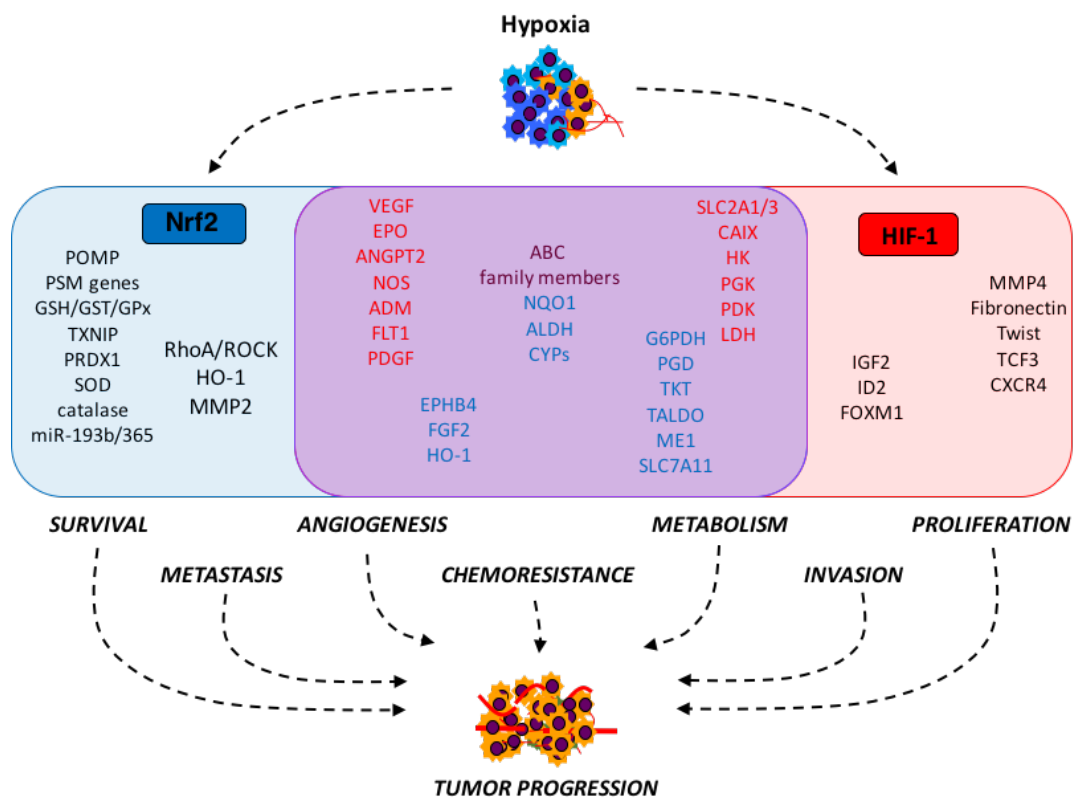
Figure 1. Tumor hypoxia activates Nrf2 and HIF-1 signaling to promote tumor progression through the activation of distinct and overlapping pathways. Through their respective target genes, Nrf2 and HIF-1 activate redundant pathways to stimulate angiogenesis, chemoresistance, and metabolic shifts, as well as unique pathways that contribute to tumor progression, such as survival and metastasis (Nrf2) and invasion and proliferation (HIF-1). Blue box: Nrf2 target genes; red box: HIF-1 target genes. Genes within the purple box (blue text: Nrf2 targets; red text: HIF-1 targets) contribute to redundant pathways. Purple text indicates classes of genes regulated by both Nrf2 and HIF-1. Nrf2: